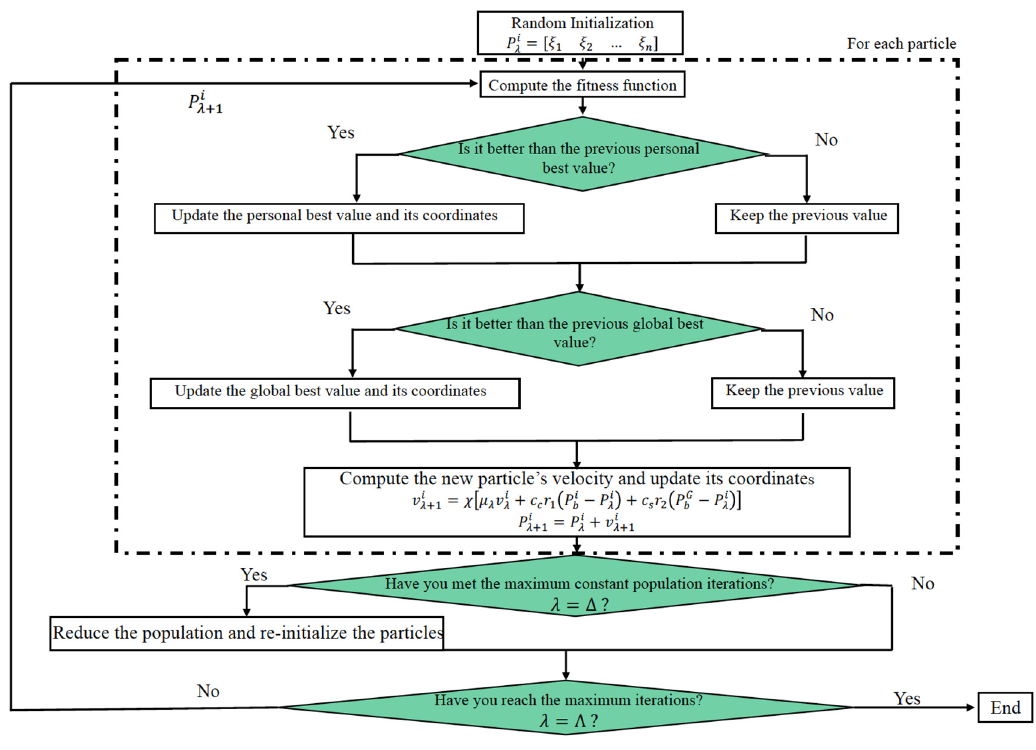
Figure A1. P D SO